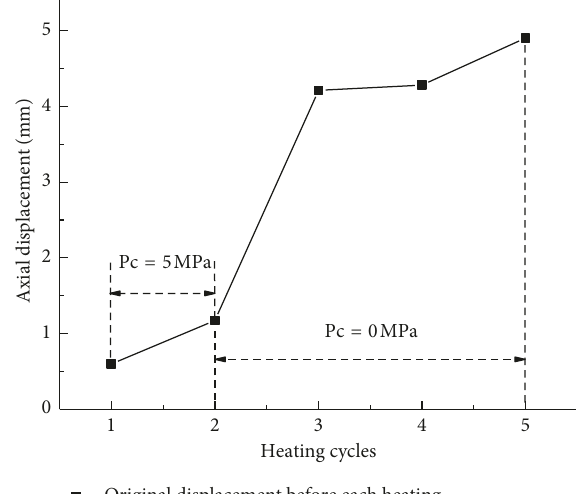
Figure 5: Axial displacement after each heating varies with the number of thermal